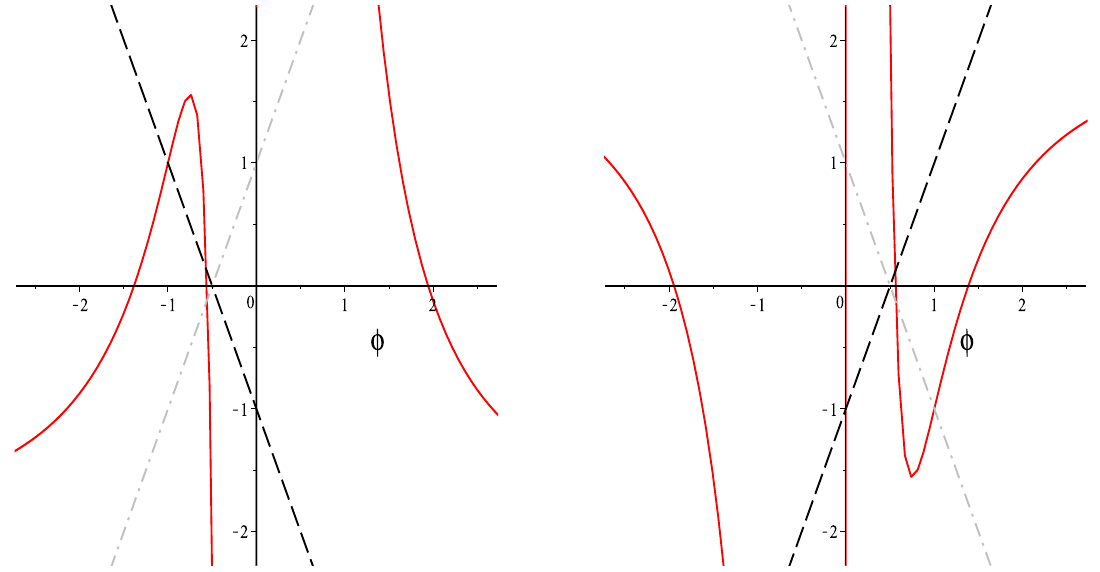
Figure 2. The functions J ( φ ) and U ( φ ) for B 2 = 1 ( left ) and B 1 = − 1 ( right ). Red solid curves show the function J ( φ ) . Black dash curves show the function U ( φ ) at Q 0 = − 1 and grey dash-dot curves show the function U ( φ ) at Q 0 =